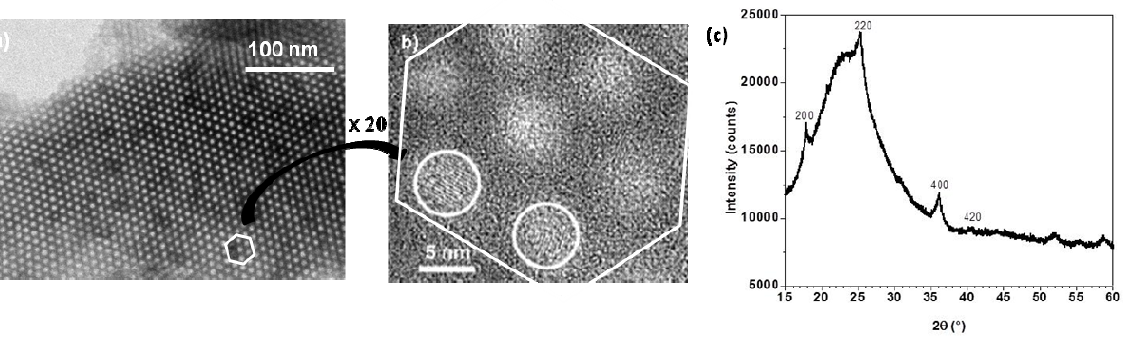
section of microtomed sample); ( b ) HRTEM micrograph of